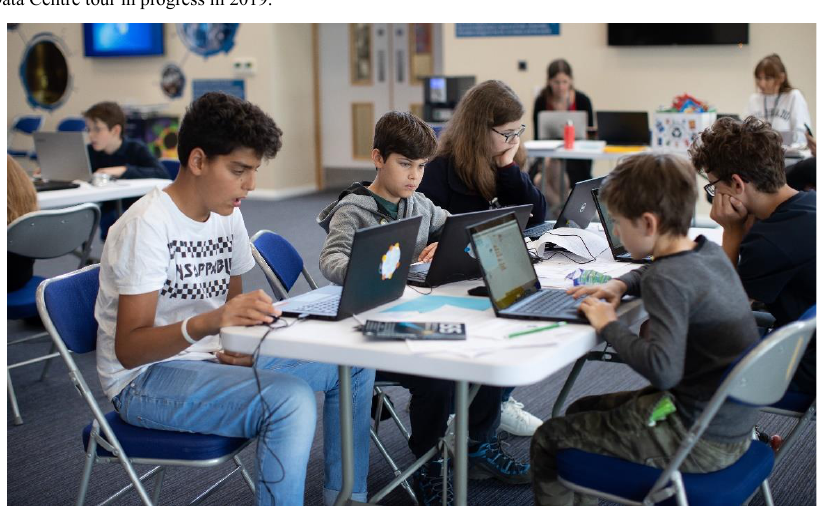
Fig. 1. A Data Centre tour in progress in 2019.